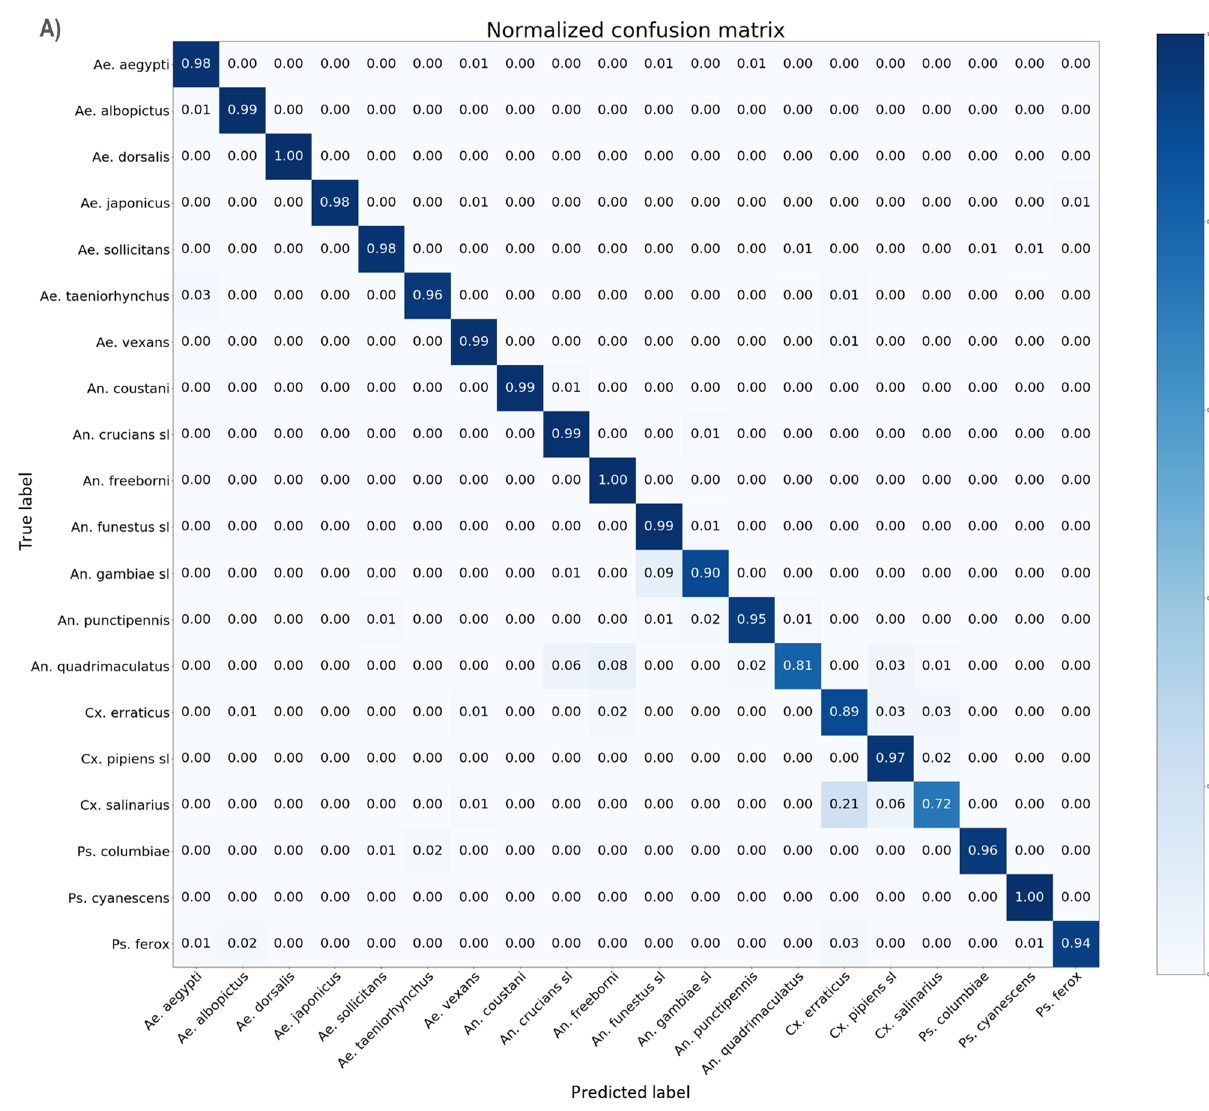
Figure 3. Mean normalized confusion matrices for species classification shows the distribution of error within species. The species classification in these confusion matrices was performed by the Tier I CNN, the closed- set Xception model. The confusion matrix conveys the ground truth of the sample horizontally, labels on the left, and the prediction of the full methods vertically, labels on the bottom. Accurate classification is across the diagonal, where ground truth and prediction match, and all other cells on the matrix describe the error. Sixteen species were known for a given fold, and 51 species were considered unknown for a given fold, with each of the twenty known species considered unknown for one fold. ( A ) The species classification independent of novelty detection shows an average accuracy of 97.04 ± 0.87% and a macro F1-score of 96.64 ± 0.96%, calculated over the five folds of Tier I classifiers, trained and tested over an average of 7174.8 and 1544.6 samples. Of the error, 73.5% occurred with species of the same genus as the true species. ( B ) The species classification as a subsequent step after novelty detection yielded 89.07 ± 5.58% average accuracy, and a macro F1-score of 79.74 ± 3.65% trained and tested on an average of 7174.8 and 519.44 samples, evaluated over the twenty-five folds of the novelty detection methods. First, a sample was sent to the novelty detection algorithm. If the sample was predicted to be known to the species classifier, which was the closed-set Xception algorithm used in Tier I, then the sample was sent to the algorithm for